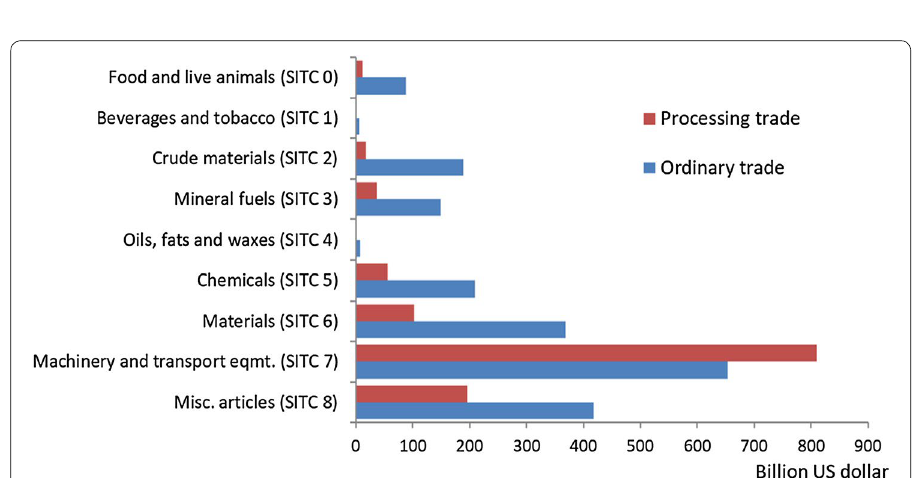
Fig. 2 Trade balance by trade regimes from 2003 to 2015. Orange, gray, and yellow bar represent ordinary, processing, and other trade, respectively. Blue line represents aggregated trade. Source : China Customs